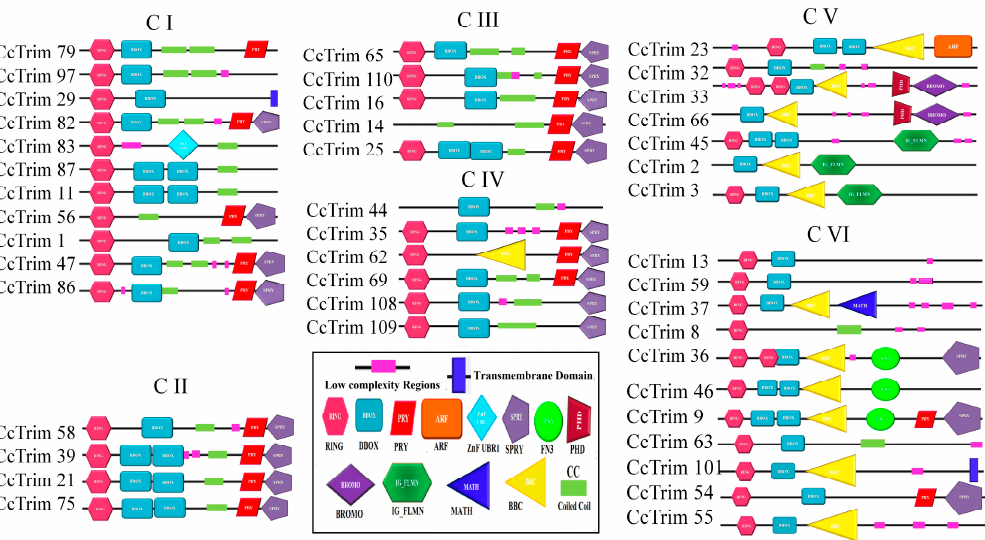
Figure 3. Phylogenetic relationship, gene structure, and motif composition of TRIM family in common carp. The phylogenetic tree of CcTrim proteins were classified into six groups based on clusters generated through phylogenetic analysis. Each cluster is marked with different color and designated as cluster 1–6. Next the blue color represents 5 and 3 prime end untranslated region, the black lines show introns and the yellow color represents exons of genes. Moreover, motif composition of the CcTrim proteins elucidated twenty different motifs that are presented in a color box having specific amino acid pattern. The black line represents non-conserved sequences. At the bottom, the unique color symbol of motifs 1 to 20 with consensus sequence is shown.